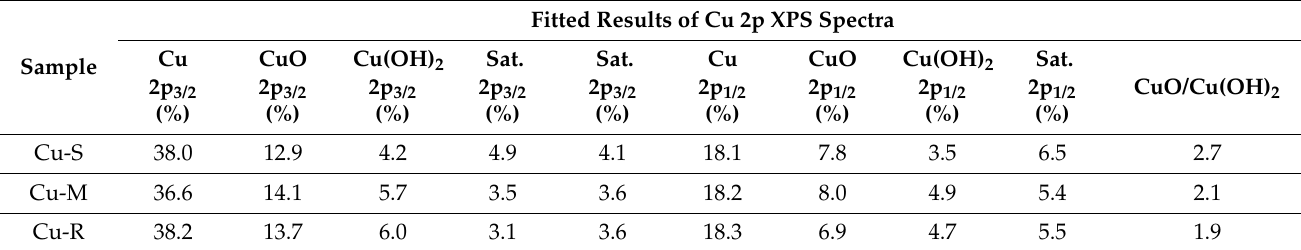
Table 2. Fitted Cu 2p XPS spectra results of Cu-R, Cu-M, and Cu-S.